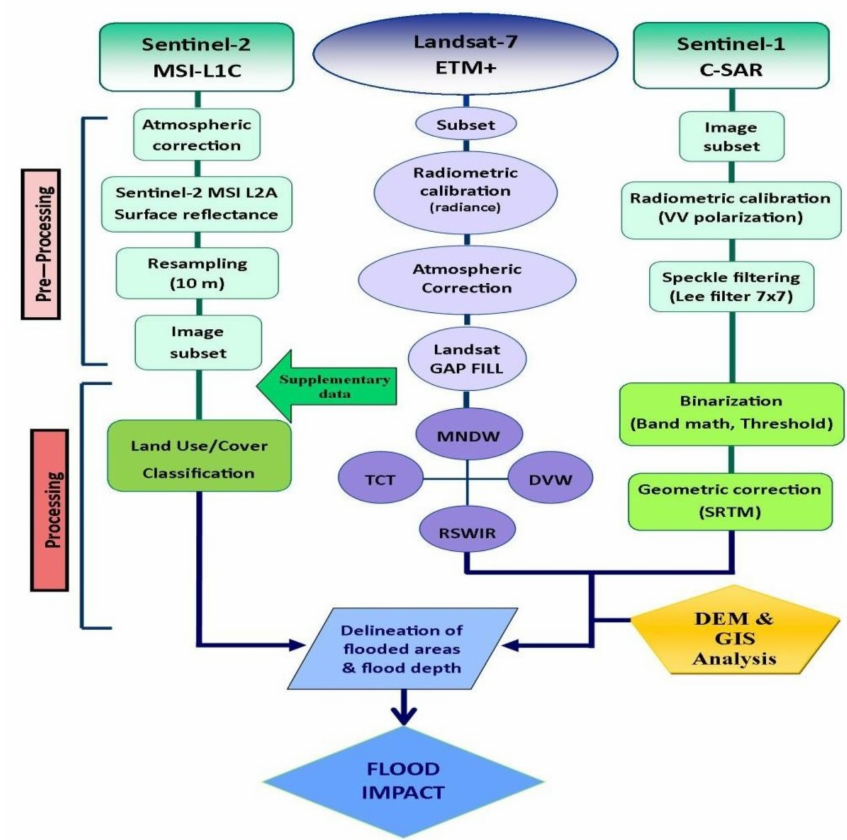
Figure 2. Flow-chart of the implemented